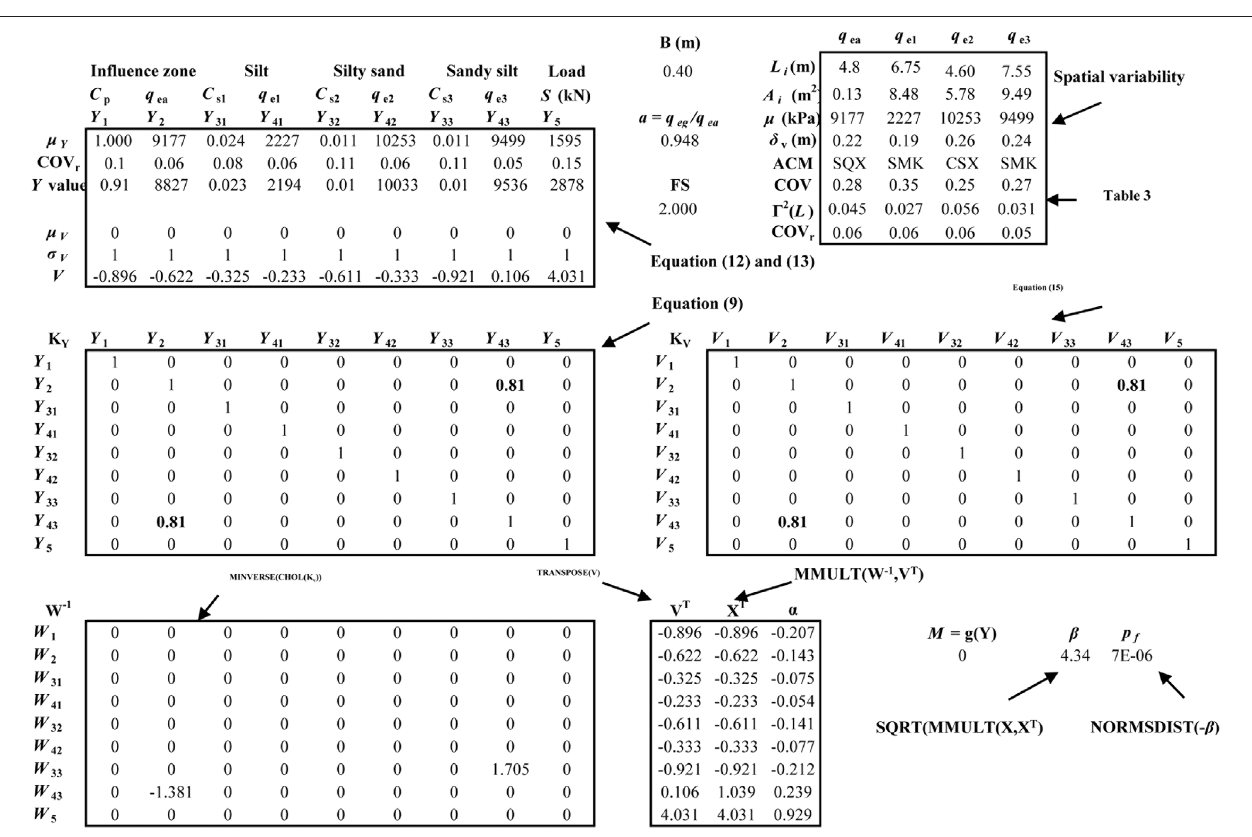
FIGURE 6 | Procedure for evaluating failure probability of pile foundations (modi fi ed from Low and Tang (1997))